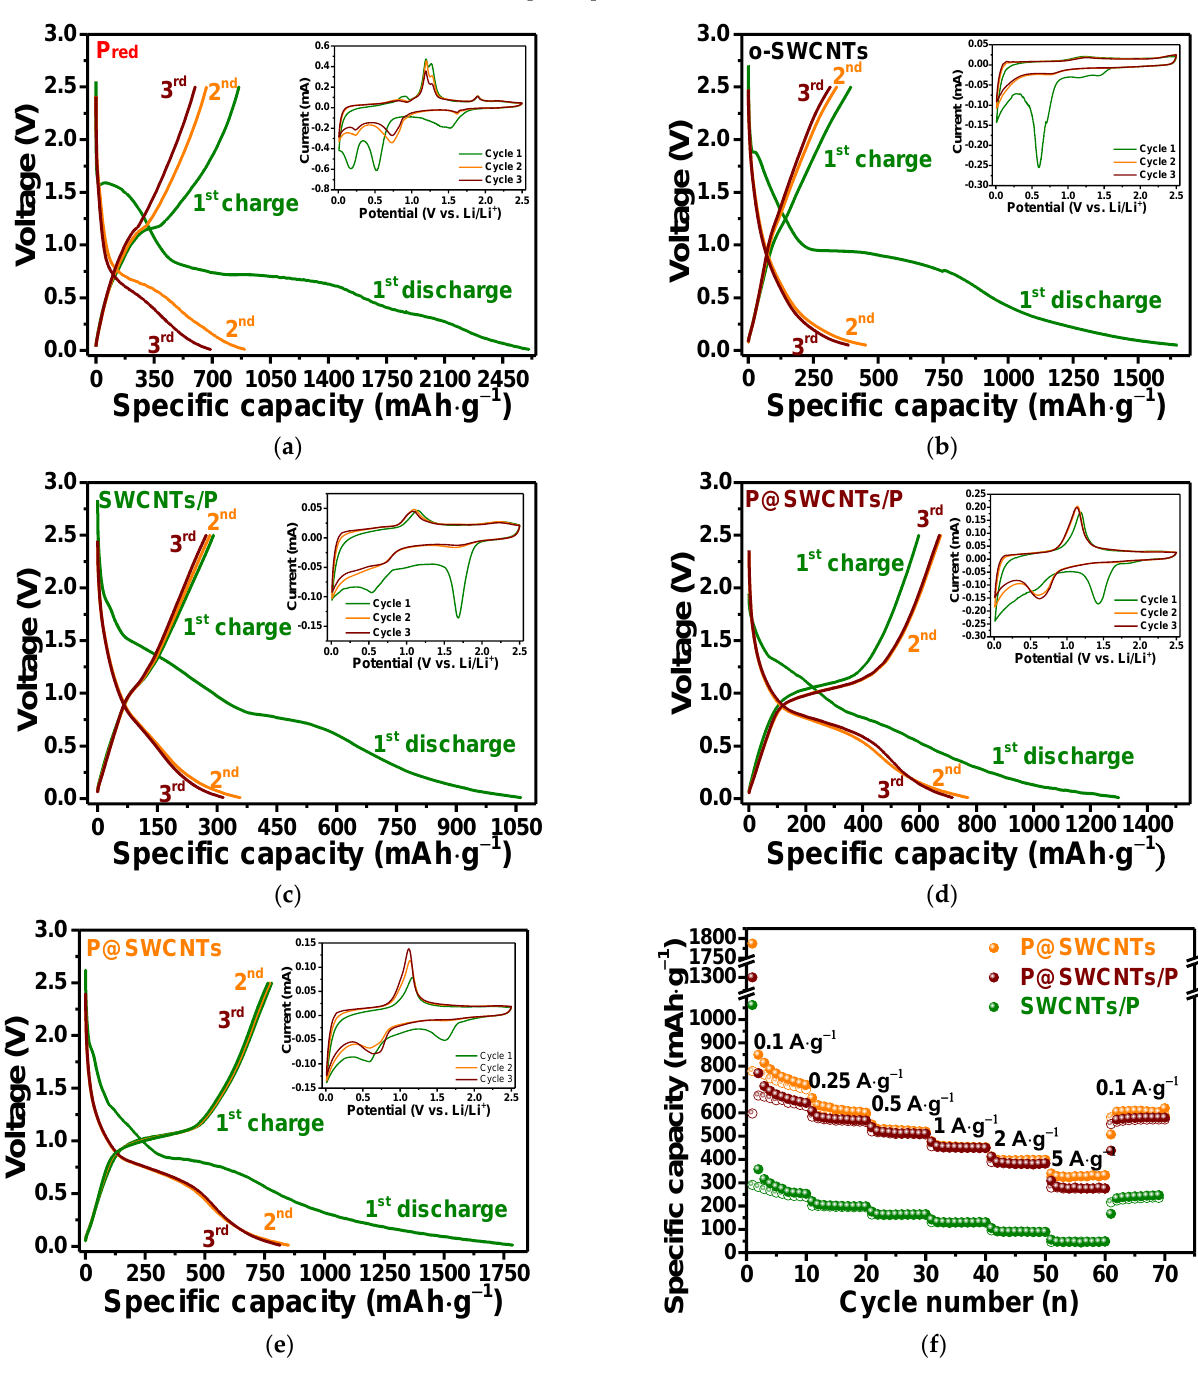
Figure 6. First three GDC curves with insets of the first three CV curves measured for ( a ) red phos- phosphorus (P red ), ( b ) o-SWCNTs, ( c ) SWCNTs/P, ( d ) P@SWCNTs/P and ( e ) P@SWCNTs; ( f ) Rate capability of composite